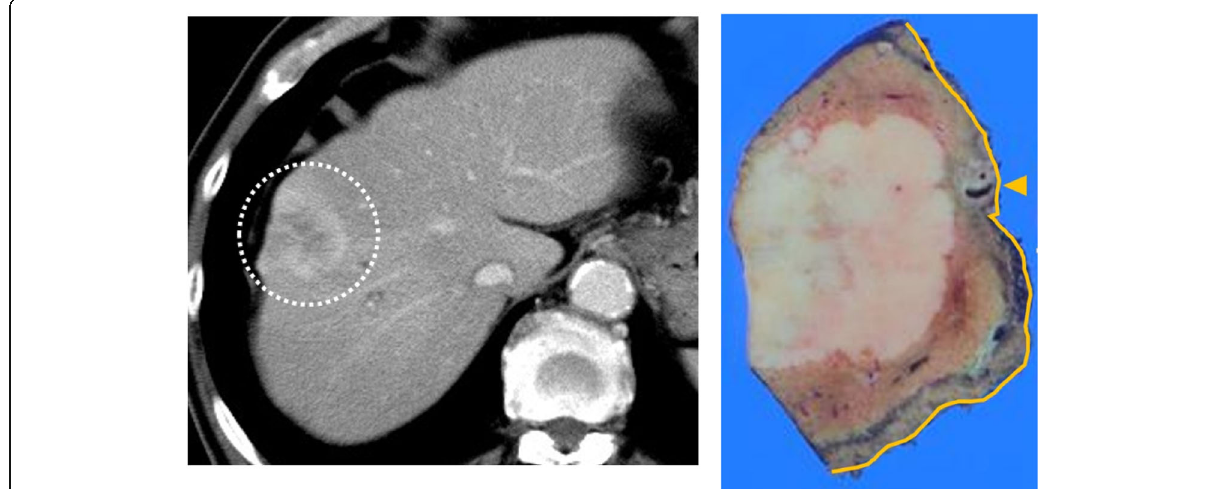
Fig. 1 Computed tomography (axial image, white-dotted line circle) revealed an enhanced tumor. A macroscopic examination of the primary tumor revealed mass-forming type growth. The S8 Glisson stump (yellow arrow) and hepatic radial margin (yellow line) were